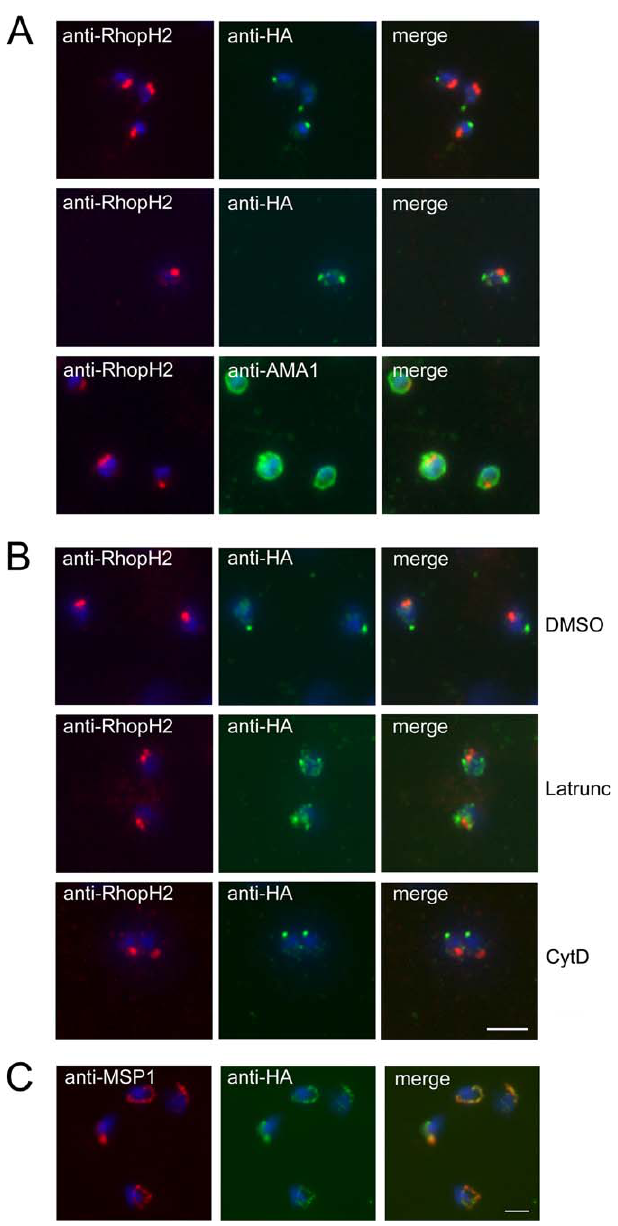
Figure 3. PfSUB2 Redistributes to the Free Merozoite Posterior in an Actin-Dependent Manner (A)IFAimagesof freemerozoitesof PfSUB2HAclone2D dual-labelledwith mAb 61.3 (anti-RhopH2) and either mAb 3F10 (anti-HA) or 4G2 (anti- AMA1). The anti-HA signal formed either a single punctate signal at the extremeposteriorofthemerozoite(top),ortwinfocilateraltoitsanterior– posterior axis (middle). Identical results were obtained using PfSUB2HA clone 10E, or using anti-RAP2 mAb H5 as the rhoptry marker (not shown). (B) Latrunculin inhibits rearward translocation of PfSUB2. Merozoites of PfSUB2HA clone 2D released into medium containing 1% (v/v) DMSO only (solvent control), or 5 l M latrunculin A (Latrunc), or 4 l M cytochalasin D (Cyt D), probed as above with mAb 61.3 (anti-RhopH2) and mAb 3F10 (anti-HA). Note that neither compound had any effect on the efficiency of schizont rupture and merozoite release, nor on AMA1 relocalisation, but both blocked erythrocyte invasion by more than 95% at the concentrations used (not shown). (C) PfSUB2 remains at the plasma membrane of the newly invaded parasite. Ring stages of PfSUB2HA clone 2D ( (cid:3) 2 h post-invasion) probed with anti-MSP1 mAb 1E1 and anti-HA mAb 3F10. Parasite nuclei are stained throughout with DAPI (blue). Scale bar represents 2 l m. DOI: